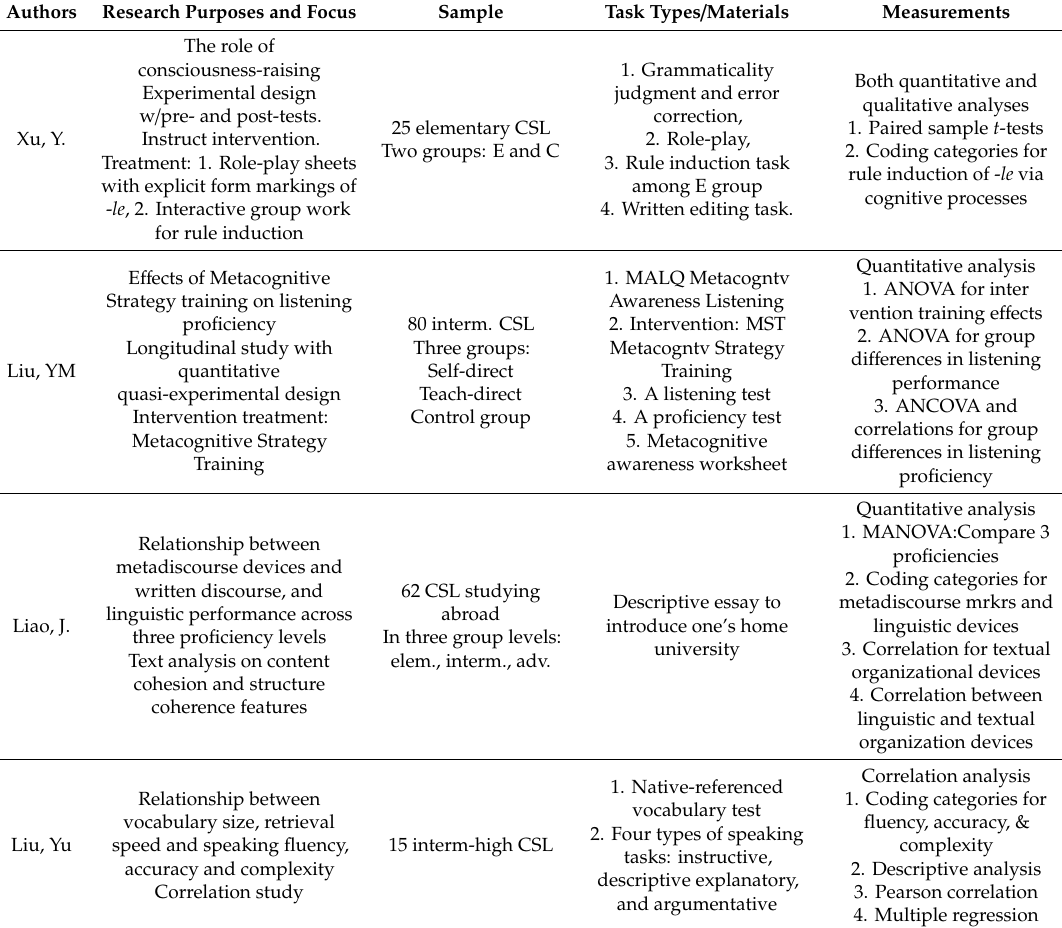
Table 1. Summary of studies adopting cognitive and L2 acquisition